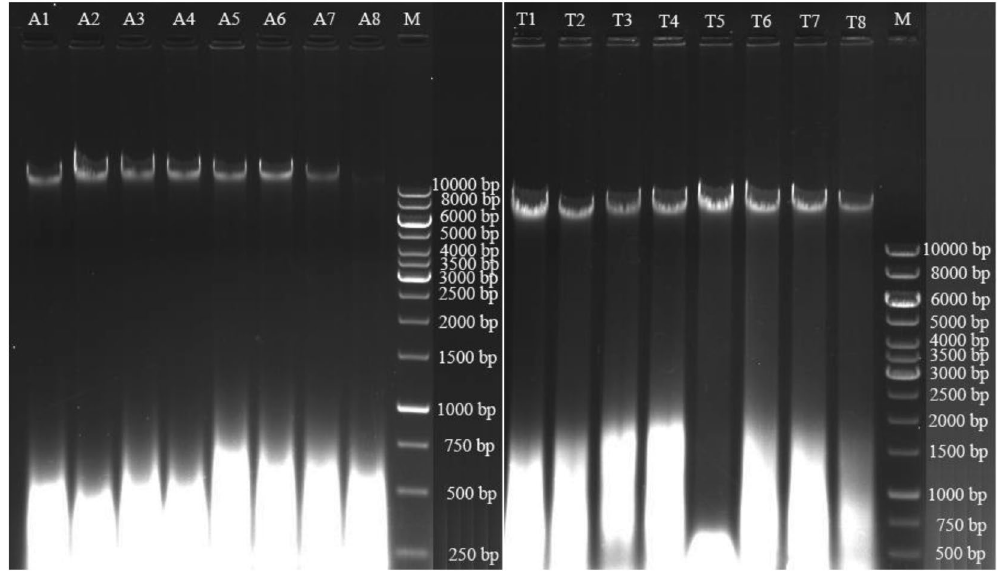
Figure 2. A representative gel of the electrophoretic pattern of whole cell nucleic acids extracted immediately after drying from mushroom specimens dried using different methods. A, Agaricus bisporus , A1: Silica gel at 22 °C; A2: Oven at 22 °C; A3: Oven at 38 °C; A4: Oven at 50 °C; A5: Oven at 60 °C; A6: Oven at 70 °C; A7: Oven at 80 °C; A8: Oven at 93 °C; M: GeneRuler 1 kb DNA ladder; T, Trametes versicolor , T1: Silica gel at 22 °C; T2: Oven at 22 °C; T3: Oven at 38 °C; T4: Oven at 50 °C; T5: Oven at 60 °C; T6: Oven at 70 °C; T7: Oven at 80 °C; T8: Oven at 93 °C; M: GeneRuler 1 kb DNA